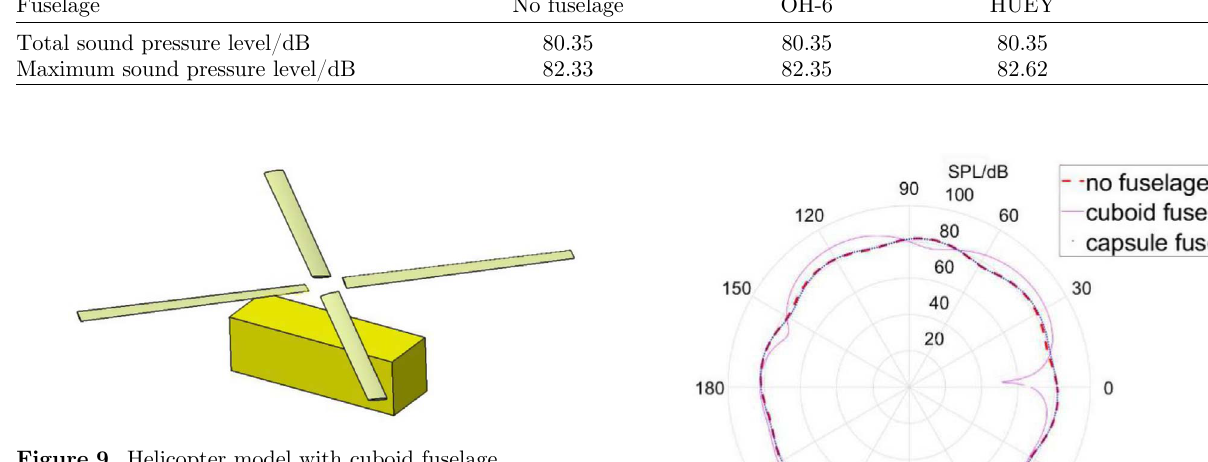
Figure 9. Helicopter model with cuboid fuselage.